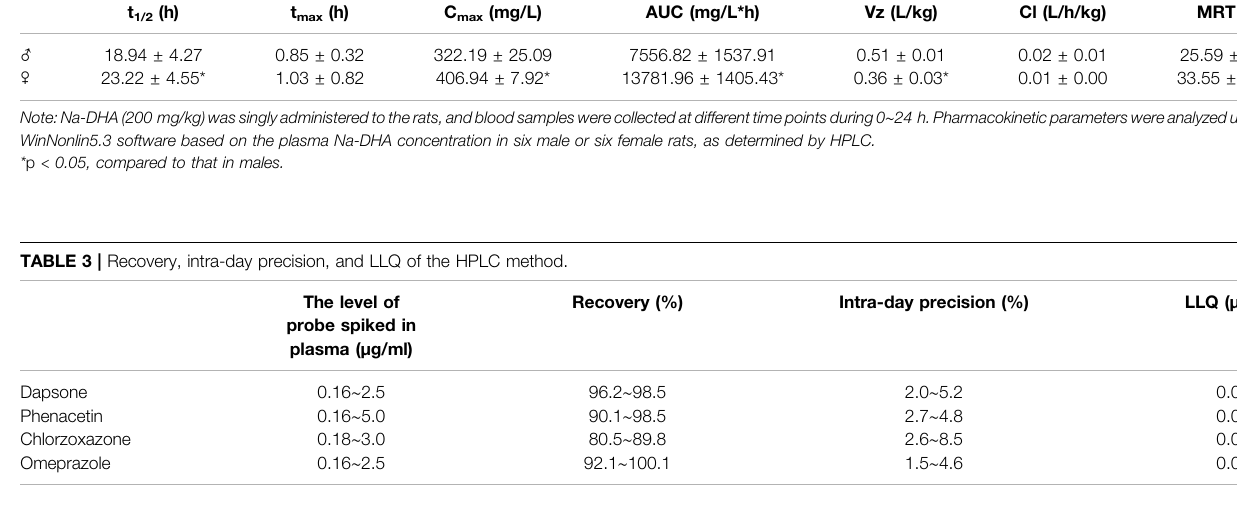
TABLE 2 | Pharmacokinetic parameters in male and female rats after a single administration of Na-DHA. t 1/2 (h)